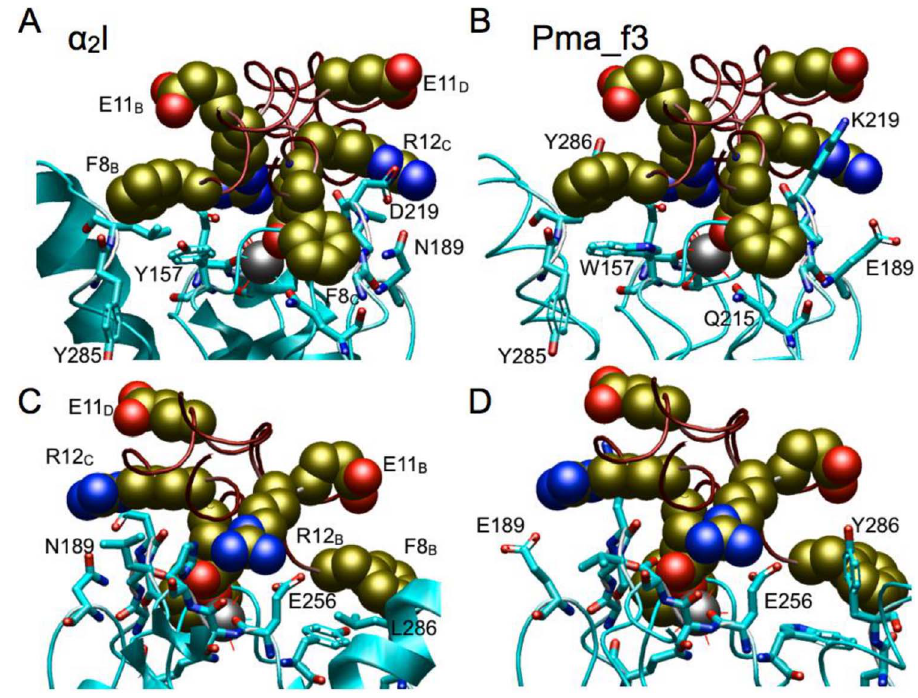
Figure 5. Views of (A, C) the structure of the a 2I domain with bound GFOGER tripeptide (PDB code: 1DZI) and (B, D) a model constructed for lamprey Pma_f3 a I domain; (C) and (D) are rotated approximately 180 6 from the view in (A) and (B). The model of Pma_f3 a I was superposed on the a 2I-peptide complex in order to place the peptide in the same relative position in the model of Pma_f3. Relevant residue side chains of the peptide are shown as CPK models and residues from the a I domains are shown as ball and stick models. For clarity, residues and water molecules binding the metal (grey sphere) at MIDAS are not shown.